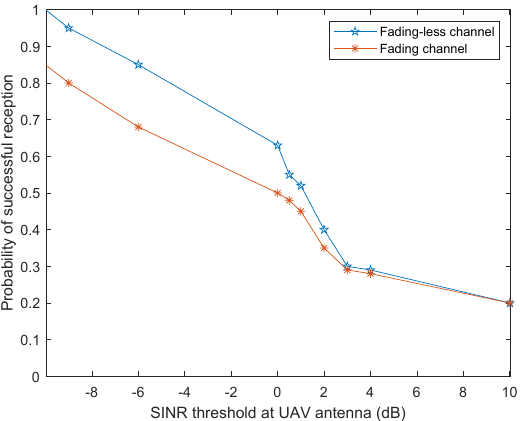
Fig. 4: The e(cid:27)ect of SINR threshold at UAV side on the performance of the system.